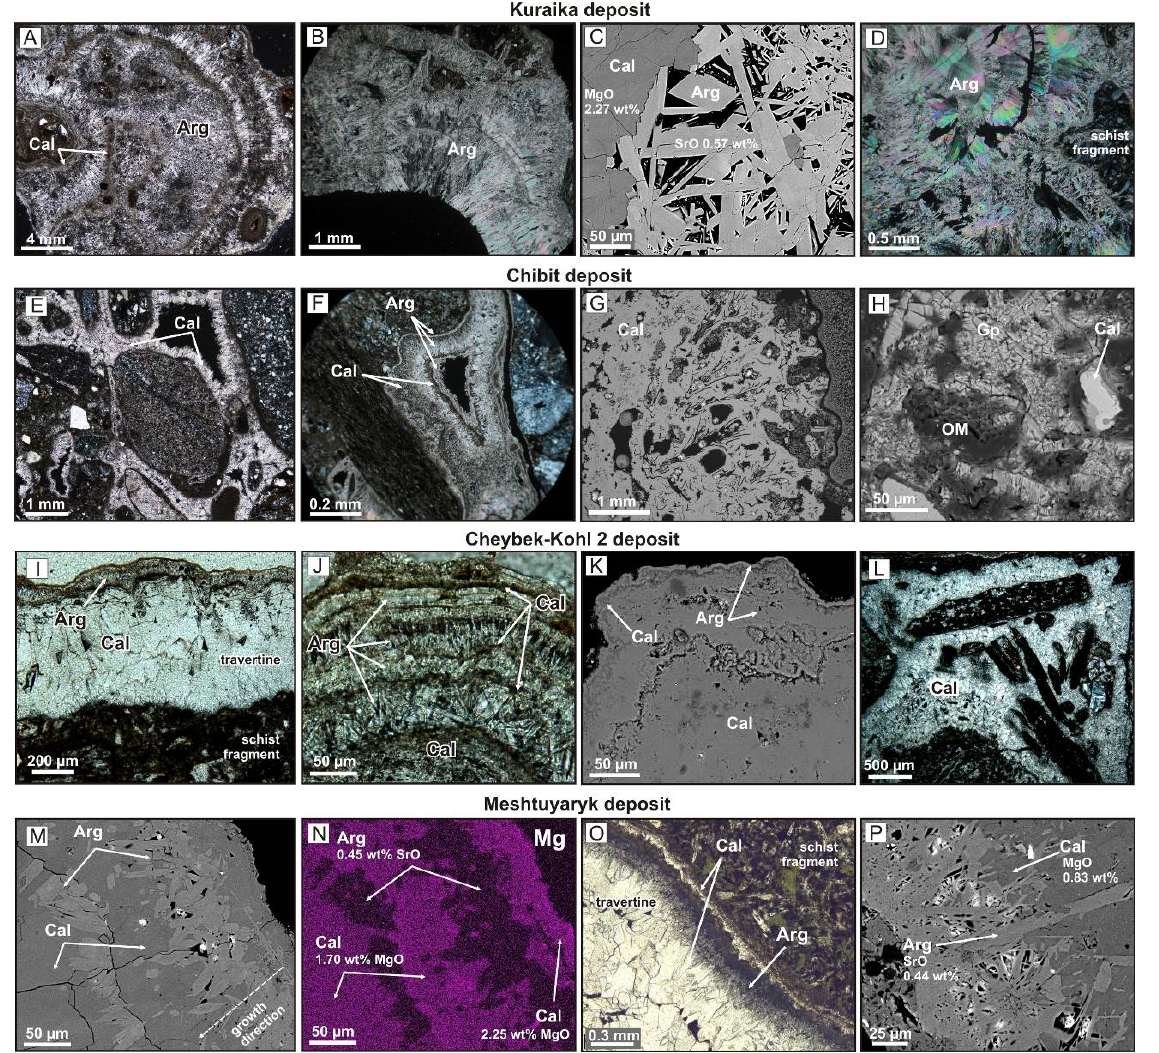
Figure 13. Photomicrographs of the fossil travertine samples and modern precipitates composed of aragonite and calcite. ( A , B , D ) Fan-shaped radiating and acicular aragonite layers. ( C )